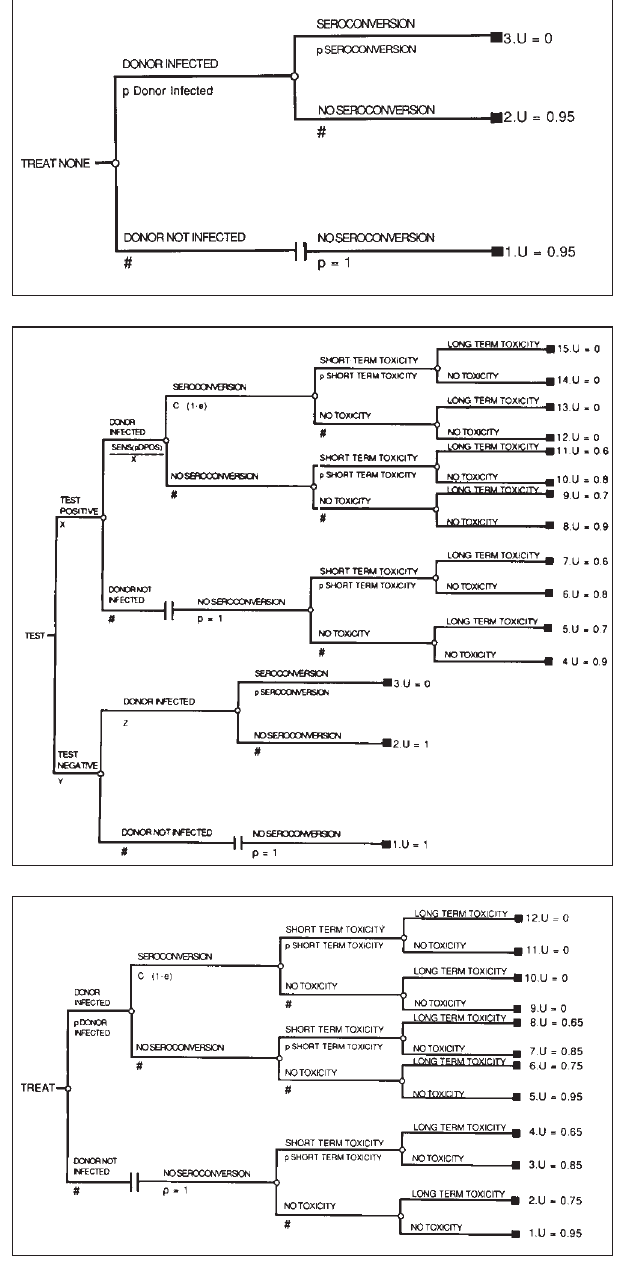
Figure 1) Three options and outcomes connected with potential